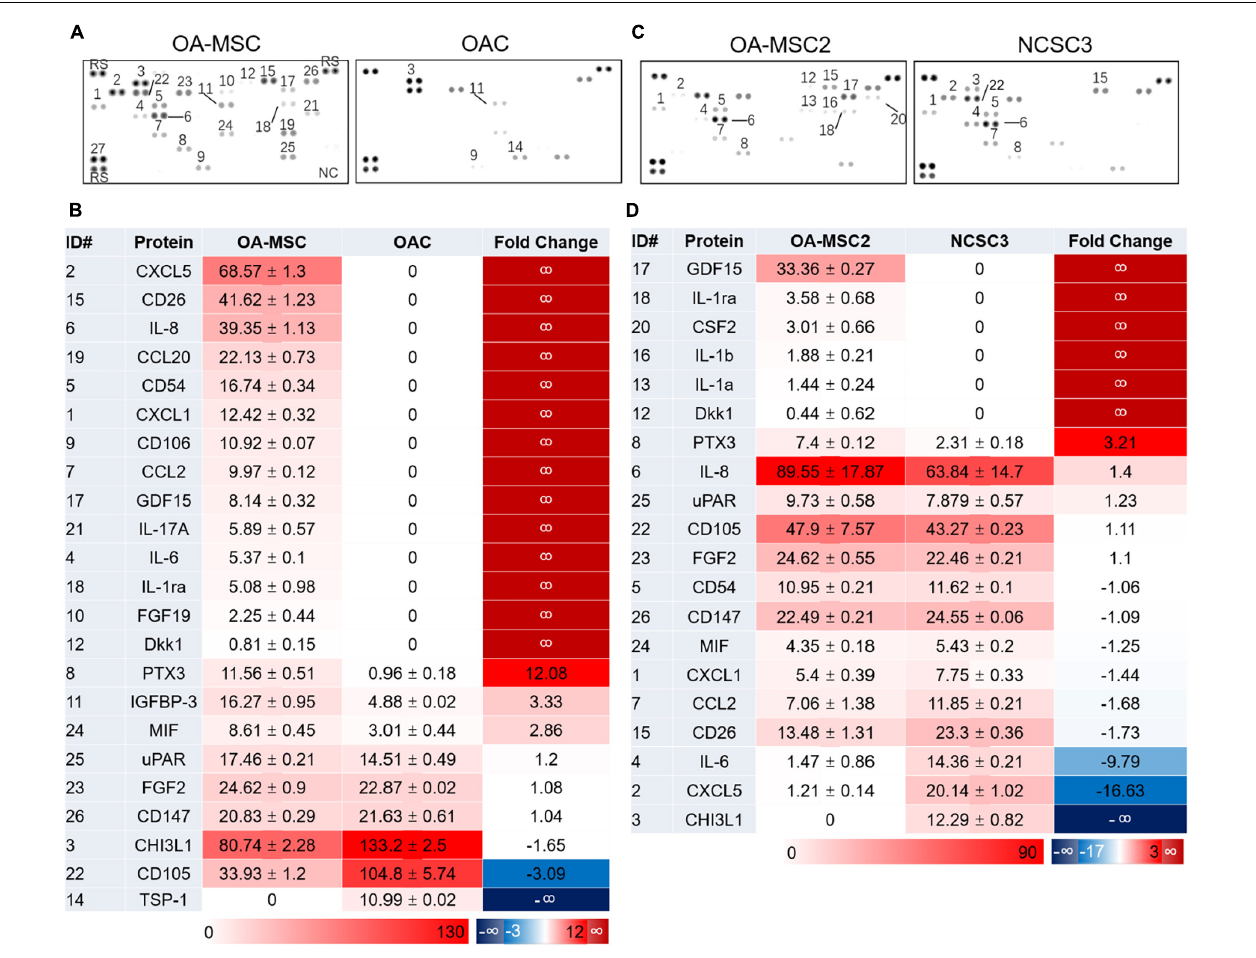
FIGURE 1 | Human cytokine protein array analysis. Differential protein expression analysis of cytokines and related proteins was performed using cell extracts of primary human cartilage cells OA-MSC and OAC (A,B) , and cell extracts of human cartilage MSC cell lines OA-MSC2 and NCSC3 (C,D) . (A,C) Cytokine protein signals were detected on the membranes of protein arrays. ID number of the protein was indicated. (B) Differential protein expression profiles of OA-MSC and OAC. The unit number of the mean spot pixel density signal was indicated for each detected protein in OA-MSC (third column) and OAC (fourth column). Red color reflects the protein expression level. The relative fold change of protein signals of OA-MSC vs. OAC was indicated in the fifth column. Red color indicates higher protein levels in OA-MSC while blue color indicates higher protein levels in OAC. (D) Differential protein expression profiles of OA-MSC2 and NCSC3. The unit number of the mean spot pixel density signal was indicated for each detected protein in OA-MSC2 (third column) and NCSC3 (fourth column). Red color reflects the protein expression level. The relative fold change of protein signals of OA-MSC2 vs. NCSC3 was indicated in the fifth column. Red color indicates higher protein levels in OA-MSC2 while blue color indicates higher protein levels in